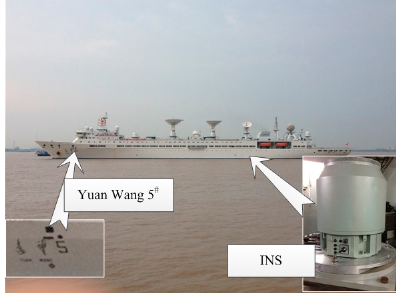
Figure 10. Ship test in the South China Sea.